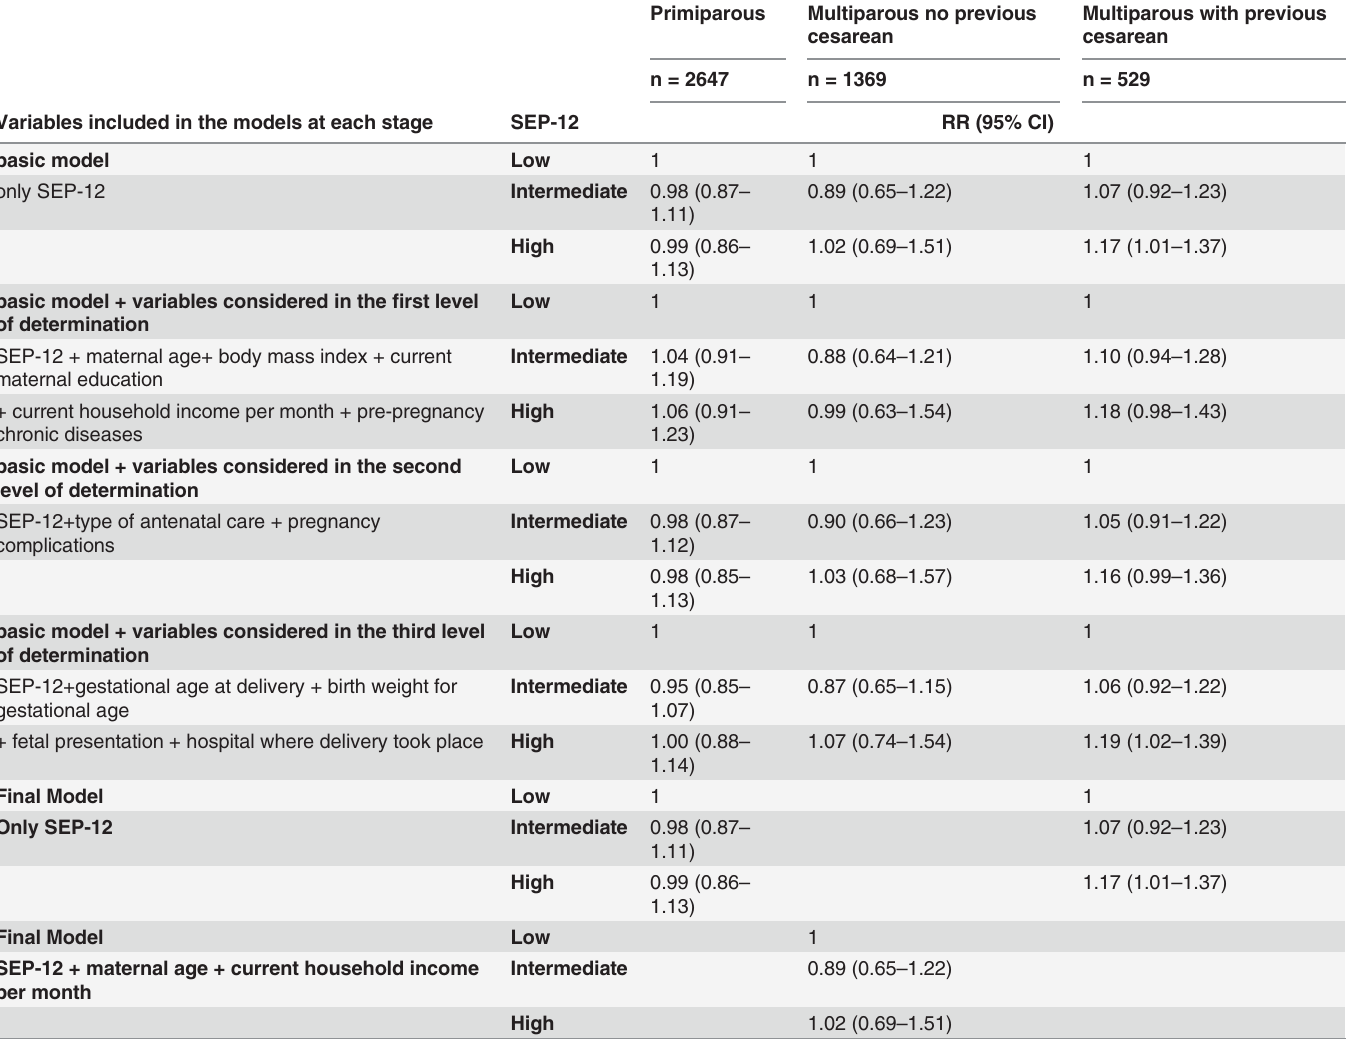
Table 5. Risk ratio for cesarean delivery by SEP-12 among women aged between 25 and 34 years old (n =